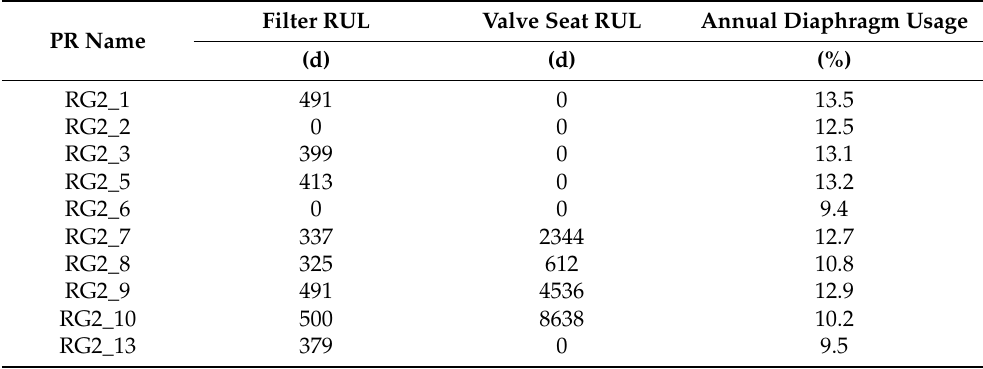
Table 2. The estimated RUL values for the filter and the valve seat and the annual diaphragm usage for the different PRs.